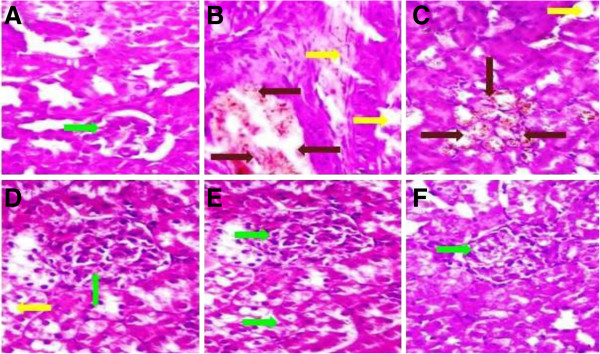
Effect of Melastoma malabathricum Linn. (MM) on kidney in different groups of rat: (A) Normal control: Normal control histopathology shown average size of glomerulus (green arrow) (B) Diabetic control: Diabetic control histopathology shown inflammatory cell in blood vessels (red arrow) and increase the deposition of fats (yellow arrow) (C) MM I (100 mg/kg): Tested drug histopathology shown inflammation in blood vessels (red arrow) and fat deposition (yellow arrow) (D) MM II (250 mg/kg): Tested drug histopathology shown fat deposition (yellow arrow) and increase size of glomerulus (violet arrow) (E) MM III (500 mg/kg): Tested drug histopathology shown normal glomerulus but slightly bigger in size (F) Glibenclamide (10 mg/kg): Glibenclamide treated animal histopathology shown the normal kidney. The samples were obtained from the same liver anatomical regions. For each group, 6 rats were examined and 50 pictures were taken. The above picture for each group was chosen randomly from the 80 pictures in this group. Original magnification, 40 ×.